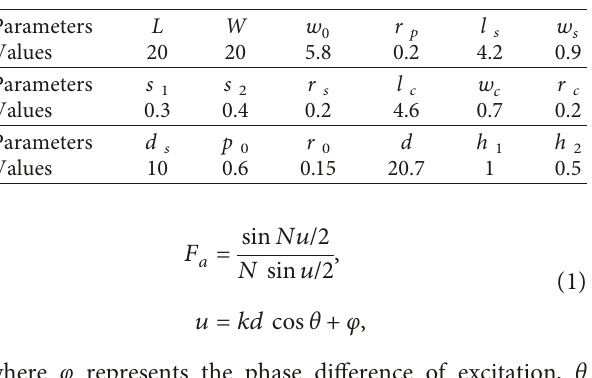
Table 1: Parameters of the presented antenna element (unit: mm).